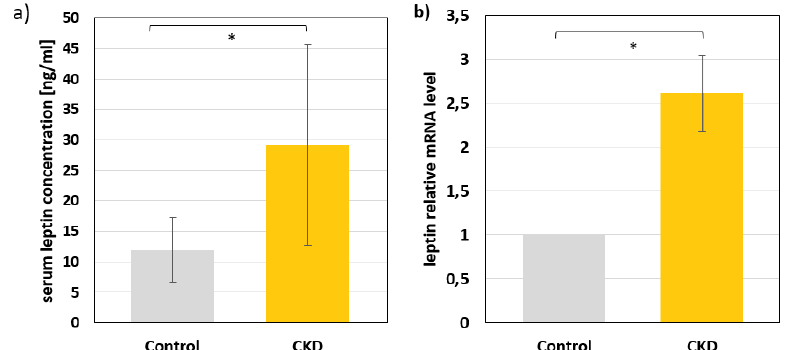
Figure 1. The serum concentrations of leptin ( a ) and leptin mRNA levels ( b ) in subcutaneous fat tissue of patients with chronic kidney disease (CKD) and control subjects. Data are shown as the mean ± SD, * p < 0.05. Serum leptin concentrations were assayed in 46 CKD patients and 57 healthy subjects. Leptin mRNA levels were assayed in adipose tissue obtained from 22 patients with CKD and 11 healthy subjects. Table 1. The percent content of the main classes of fatty acids in the serum of patients with chronic kidney disease (CKD) and the control group. The data are presented as fatty acid proportions (%). Values are the mean ± SD.